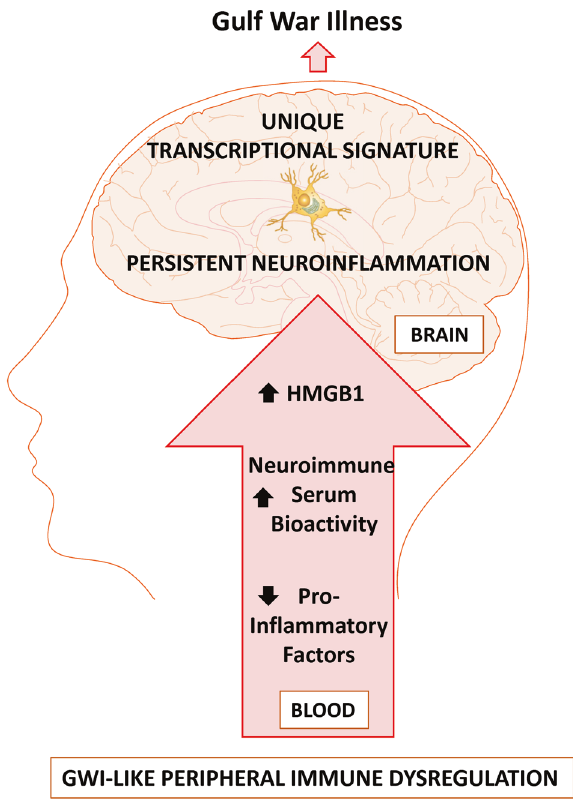
Fig. 6 Circulating HMGB1 is elevated in Gulf War Illness and drives persistent neuroin fl ammation. Peripheral immune perturba- tion from IP LPS administration in the murine LPS Persistent Neuroin fl ammation model can mimic peripheral immune dysregu- lation similar to GWI that results in persistent neuroimmune bioactive serum that can modify the microglial pro-in fl ammatory response, long after the prototypical pro-in fl ammatory response in the serum has resolved. Inhibition of HMGB1 attenuates the persistent pro-in fl ammatory response in the brain and administra- tion of recombinant HMGB1 can trigger neuroin fl ammation. Circulating HMGB1 is upregulated in the serum of Gulf War Veterans and in the bioactive serum of mice during the LPS-induced persistent neuroin fl ammation. Isolated microglia reveal a unique Persistent Pro-in fl ammatory Microglia transcriptome that is trig- gered in part by HMGB1, which may provide important insight into the persistent nature of neuroin fl ammation in of these factors have been associated with GWI and GWI-like symptoms. For example, the C3 gene encodes for complement C3 and is not only a critical component of the complement system, but it is: activated in human AD brains, required for neurodegen- eration in mouse models of amyloidosis and tauopathy [78], and has been previously shown to be upregulated in the cortex of a mice model of GWI [55]. CXCL10 (IP-10) is a small-molecular- weight pro-in fl ammatory chemokine produced by many cells, including microglia [79] and the CXCL10 protein was found upregulated in GWI serum and serum from myalgic encephalo- myelitis patients [21]. While we found an increase in Cxcl10 gene expression 7 days after LPS administration in the mouse model (Fig. 4F), we did not see any signi fi cant changes in the serum levels of the CXCL10 (IP-10) protein. We also show that Cd72 is elevated in response to HMGB1-induced persistent neuroin fl am- mation (Fig. 4C), where Cd72 is a receptor expressed on microglia [80] and is a gene commonly upregulated in the brain after repeated LPS administration [81]. However, at present, there are no other reports testing the association of Cd72 with GWI models